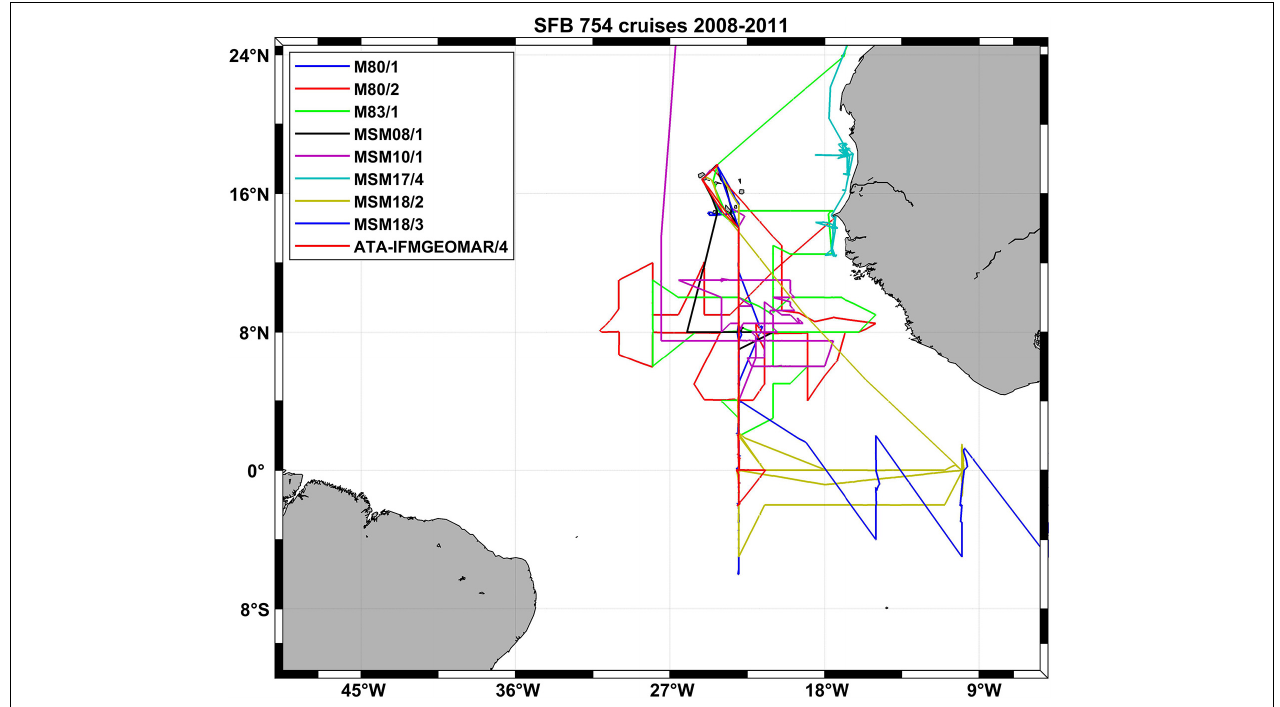
FIGURE 2 | Cruise tracks of nine SFB 754 cruises in the Atlantic Ocean in the first funding period of the project (2008–2011).